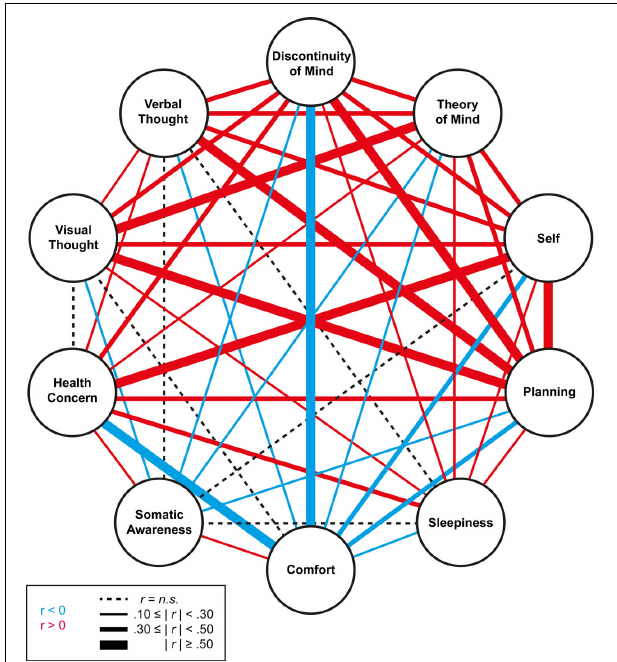
FIGURE 3 | The intricate web of associations between the 10 dimensions of mind wandering. To facilitate inspection of the many significant positive ( red ) or negative ( blue ) model-estimated factorial correlations among the 10 dimensions of mind wandering ( Figure 2A ), these have been shown as pair-wise connections with the line thickness indicating the strength of the effect.